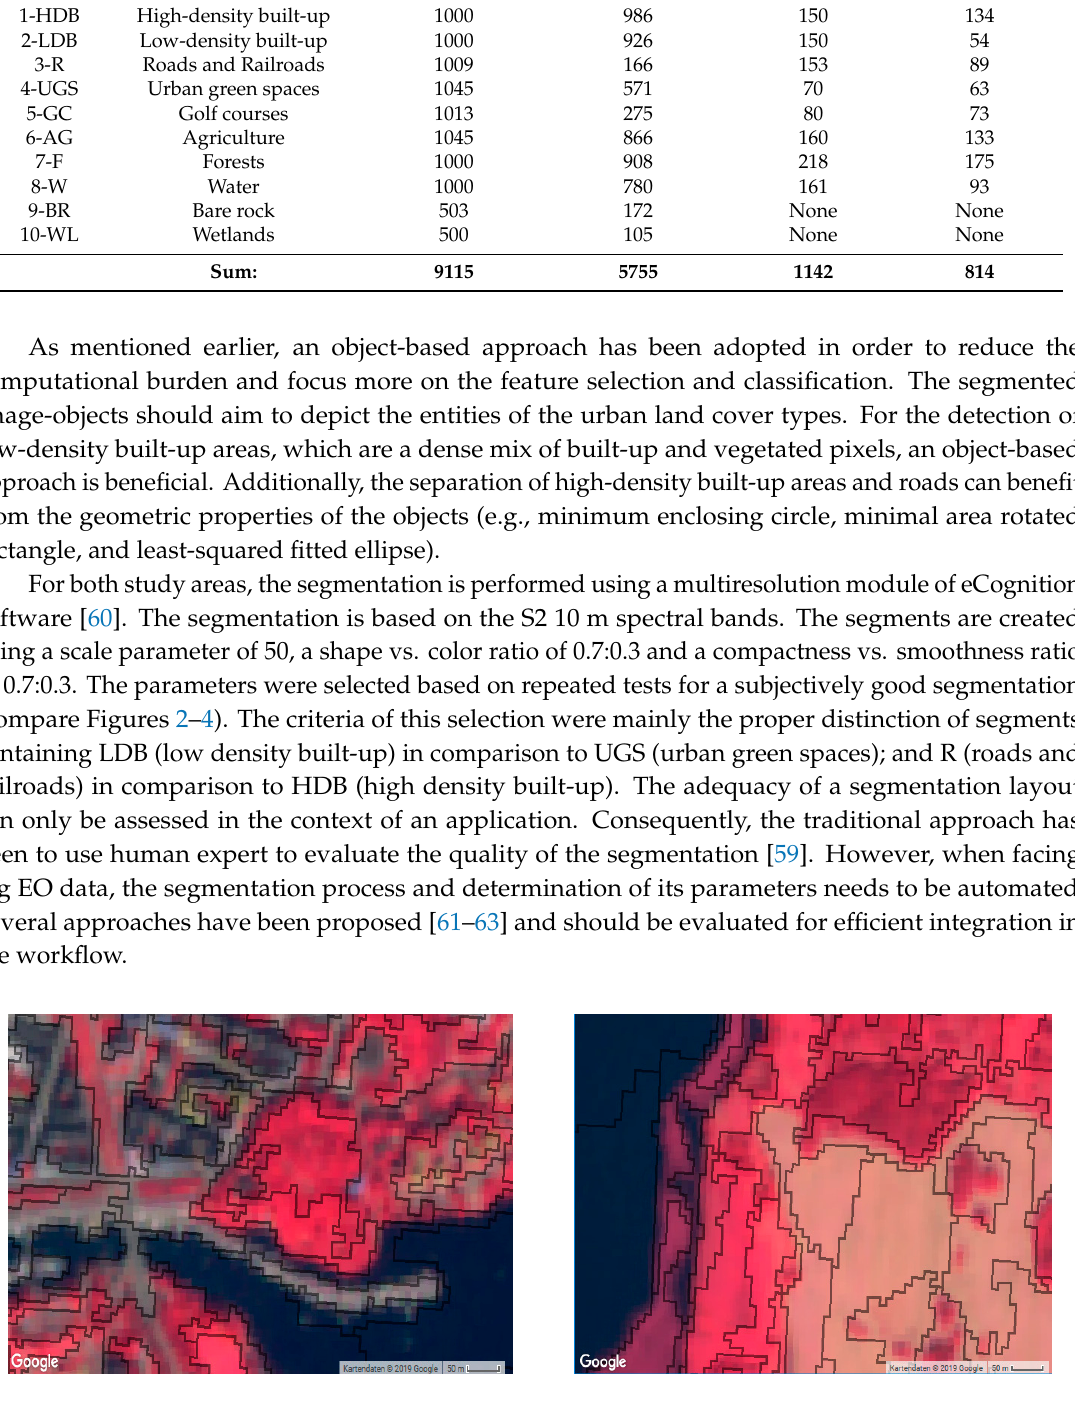
Figure 2. Generated segments: (left) high-density and low-density built-up, transportation, water, and urban green space land cover/land use classes in Stockholm’s urban center; (right) agricultural, forest, water, and wetland land cover/land use classes in Stockholm’s periphery.